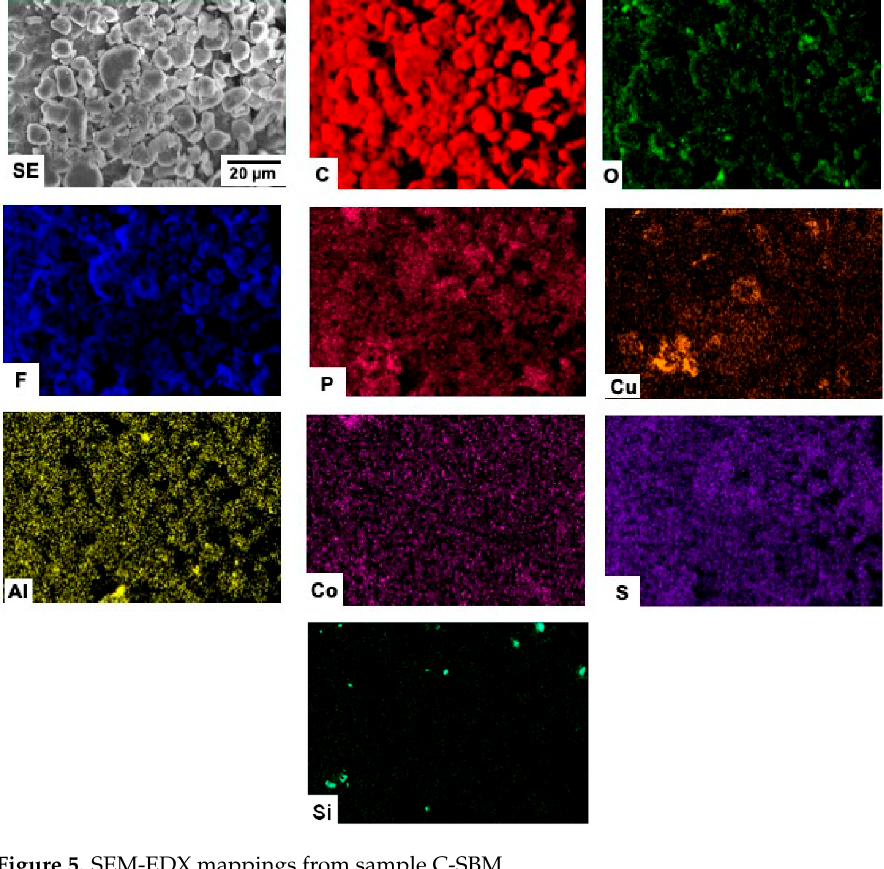
Figure 5. SEM-EDX mappings from sample C-SBM.